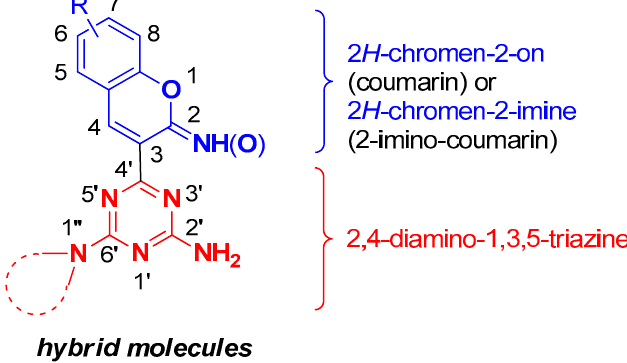
Figure 1. General structure of the hybrid molecules composed of 2,4-diamino-1,3,5-triazines and 2-imino-coumarins or coumarins.